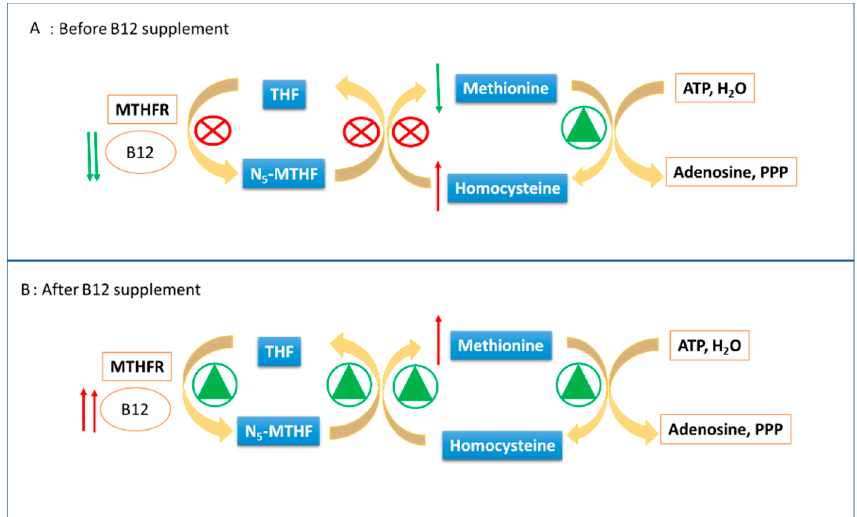
Figure 4. Met and hcy metabolic pathway before and after Vit. B12 supplementation. Met and hcy metabolic pathway before and after Vit. B12 Methylenetetrahydrofolate reductase = MTHFR; THF = tetrahydrofolate; Adenosine 5 ′ -Triphosphate = ATP; N 5 - methyltetrahydrofolate = N 5 -MTHF; Triphosphate = PPP.